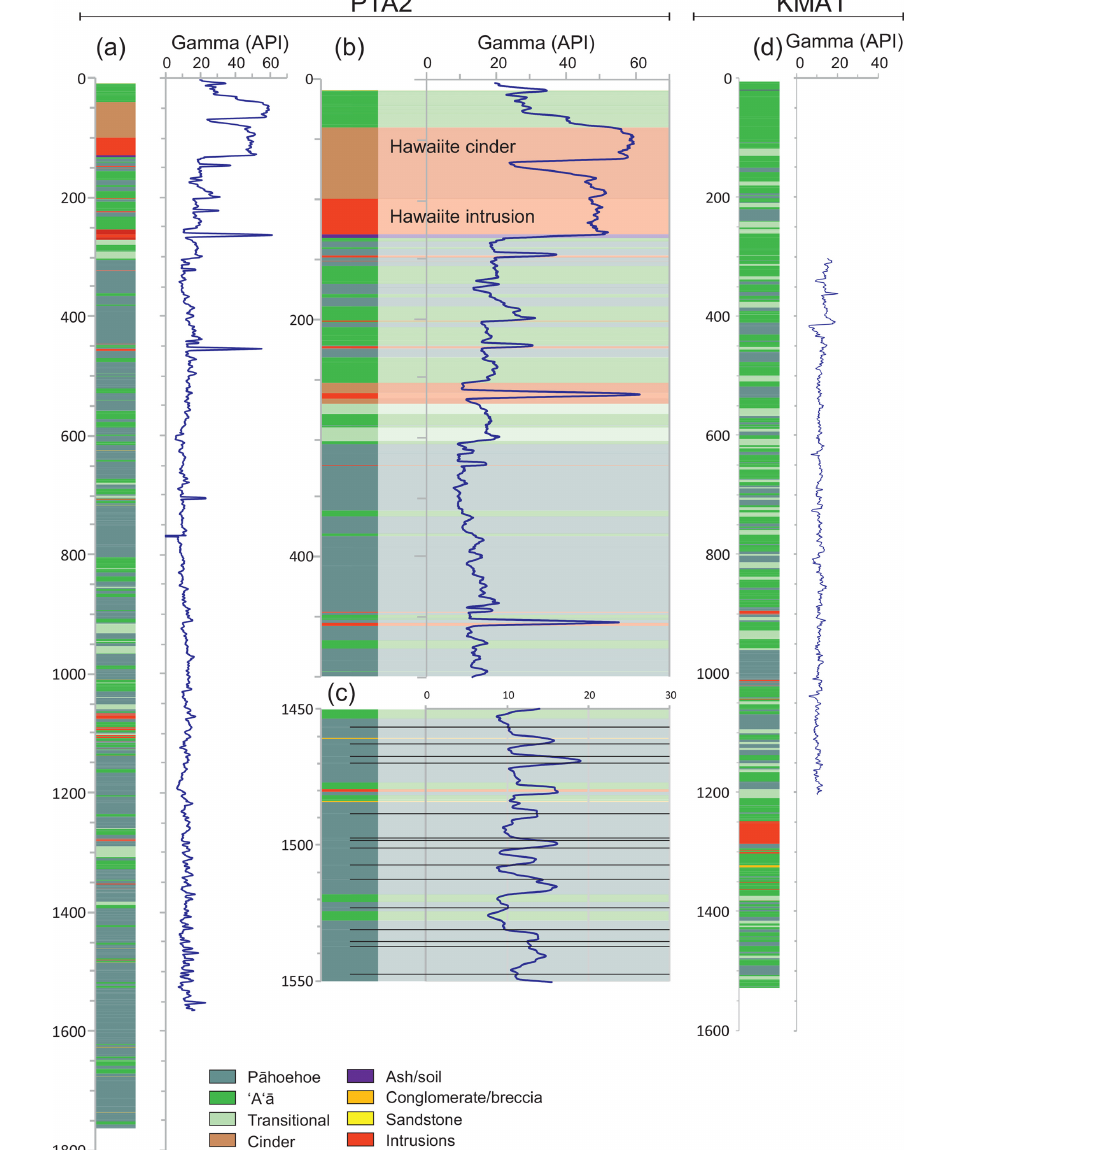
Figure 7. Gamma ray log results compared to volcanic facies in the PTA2 and KMA1 boreholes (a, d) . Two panels in the center display key intervals from PTA2 at a larger scale (b, c) . Black lines display flow boundaries within p ¯ ahoehoe packages in the bottom middle